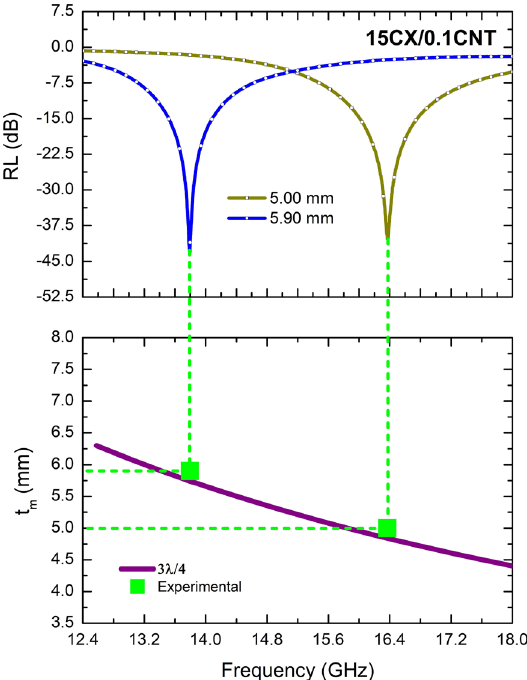
Figure 12. Relationship between the RL peaks frequency and calculated thickness of